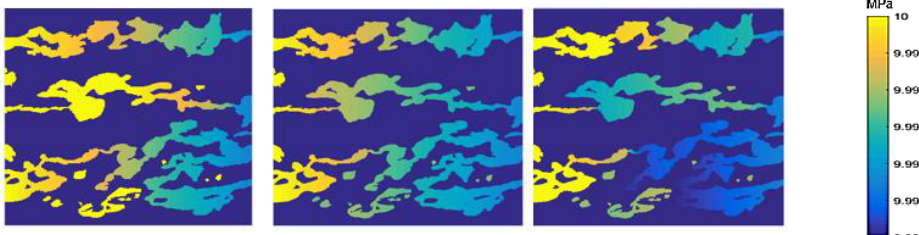
Figure 22. Simulation results under different oil phase viscosities.